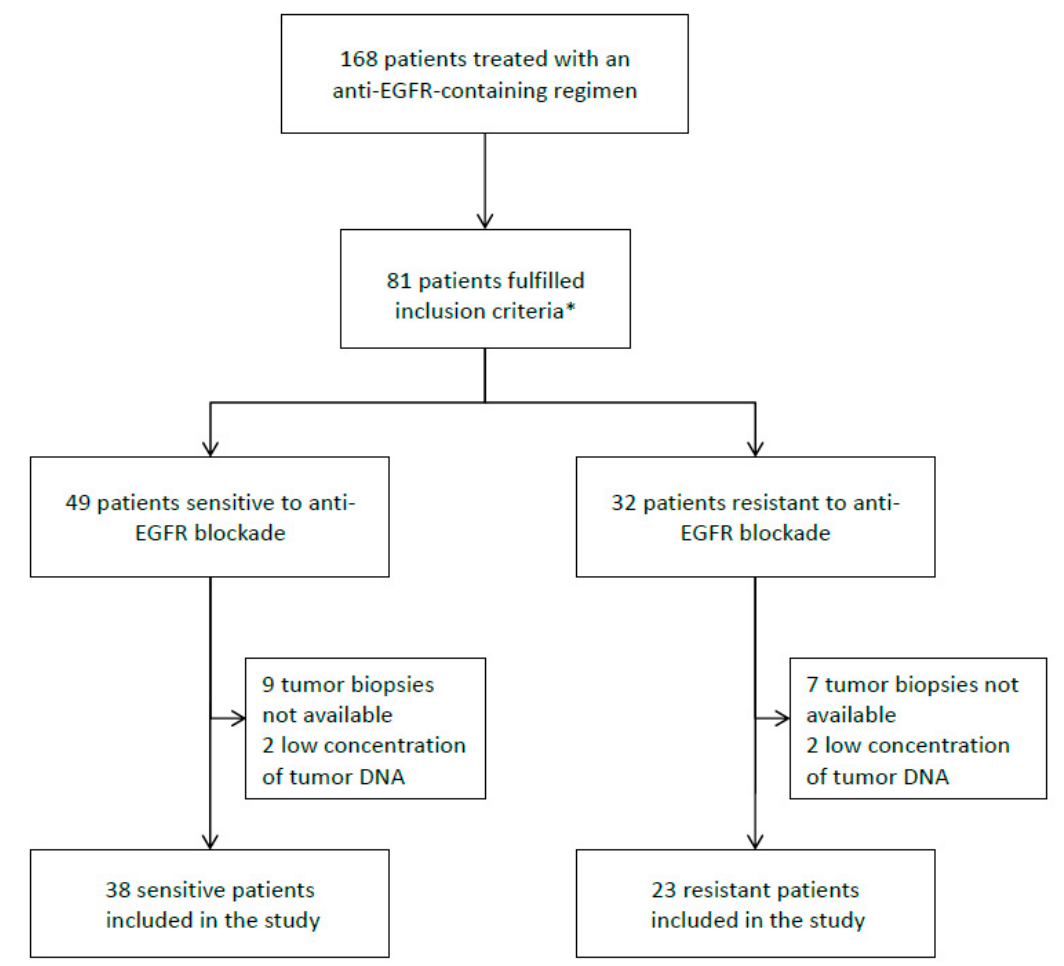
Figure 1. Flow chart of patient selection. * Inclusion criteria: patients ≥ 18 years, with an Eastern cooperative oncology group (ECOG) performance status ≤ 2 and RAS wild-type tumors. Patients had to be sensitive (patients achieving complete or partial response at the first CT-scan or disease stabilization lasting at least 6 months) or resistant to anti-EGFR blockade (patients showing disease progression at the first CT-scan). Table 2. Baseline patient characteristics.